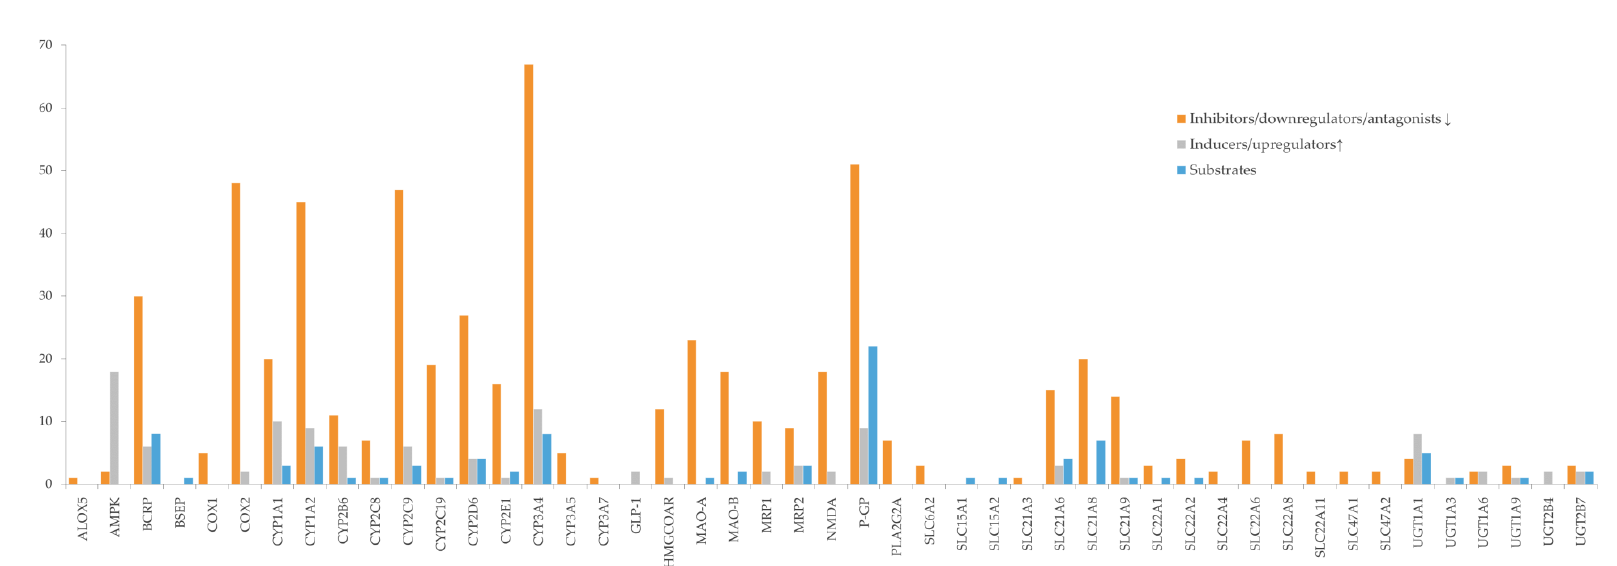
Figure 6. Effect of bioactives on targets (enzymes, transporters, and receptors).